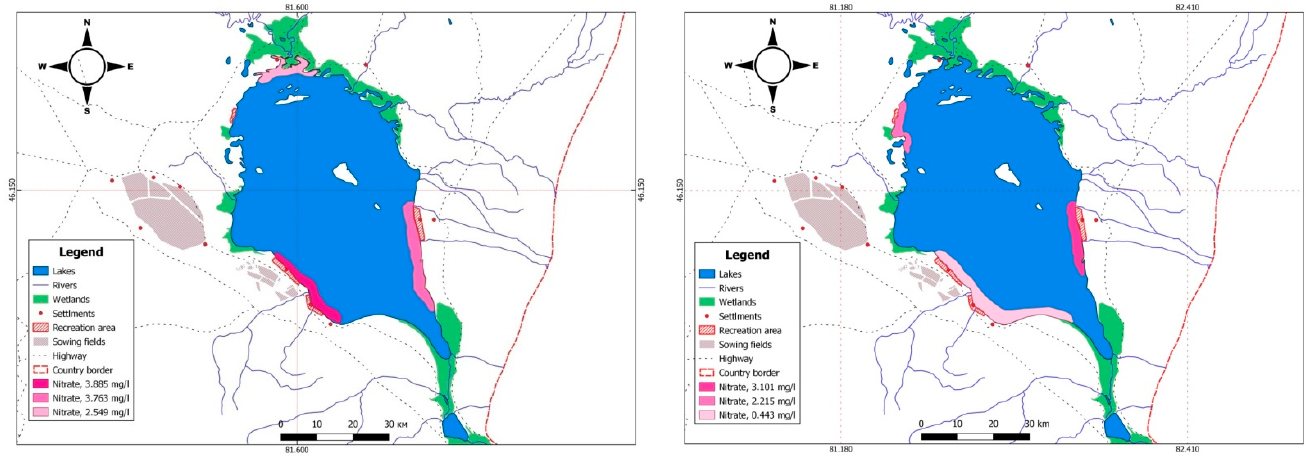
Figure 6. Distribution of nitrate ions in Lake Alakol in 2020 (left) and 2021 (right).